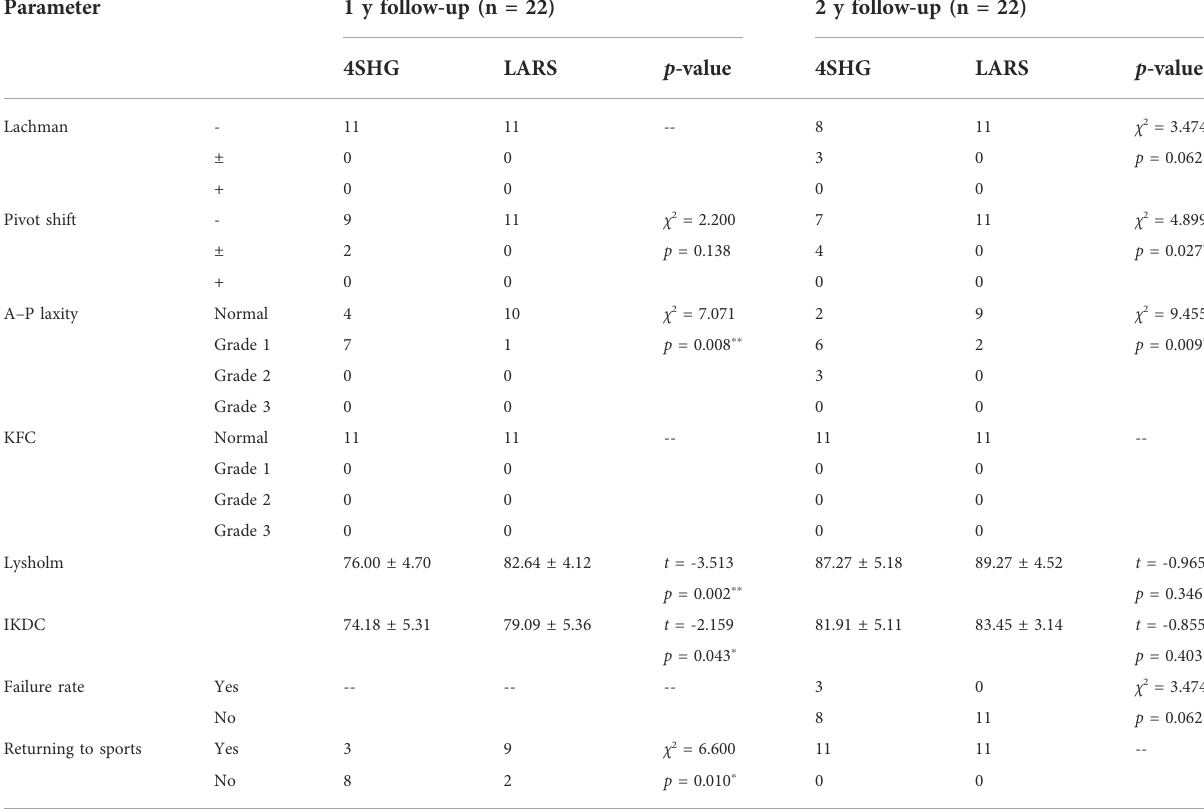
TABLE 2 Comparisons of ef fi cacy, safety, and functional outcomes between the 4SHG and LARS subgroups in high PAL patients.